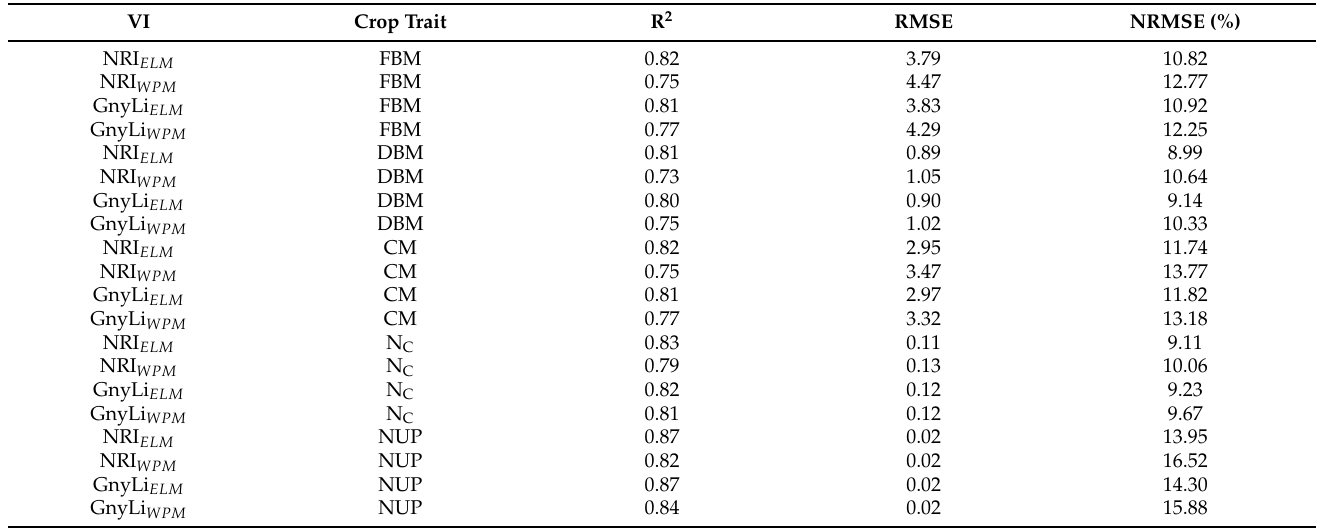
Table 6. Regression analyses’ results for the VIs as estimators for the sampled ground truth data (FBM: fresh biomass, DBM: dry biomass, N C : N concentration, CM: crop moisture, NUP: N uptake) of the 18 destructive sample plots. ( p < 0.001 for all regression